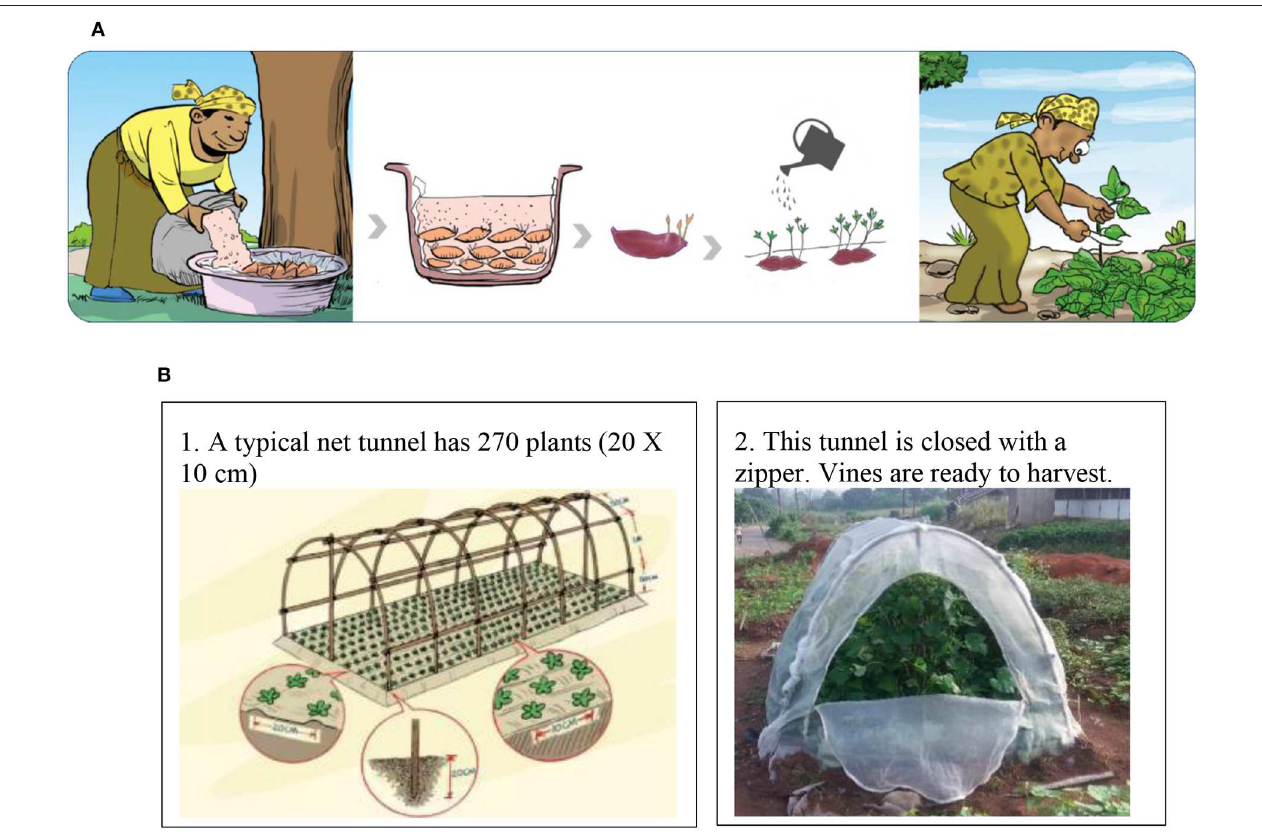
FIGURE 4 | Technologies to enhance access to seed in drought prone areas (A. Triple S) and to protect a stock of high quality planting material from insect vectors (B. Net tunnels) developed under the SASHA research program. (A) Triple S is a root based method where small and medium roots are stored in layers of sand in the home during the dry season, then planted out in a nursery bed 6–8 weeks prior to the start of the rain and watered twice a week. On average one root gives 40 cuttings (each 30cm long). (B) Net tunnels protect hardened disease-free cuttings obtained usually from national research programs from insect vectors. They are appropriate for use by vine multipliers in high virus pressure areas, enabling them to retain their own stock of starter material. Under good management, a net tunnel lasts 3 years. (Credit on photo: K.